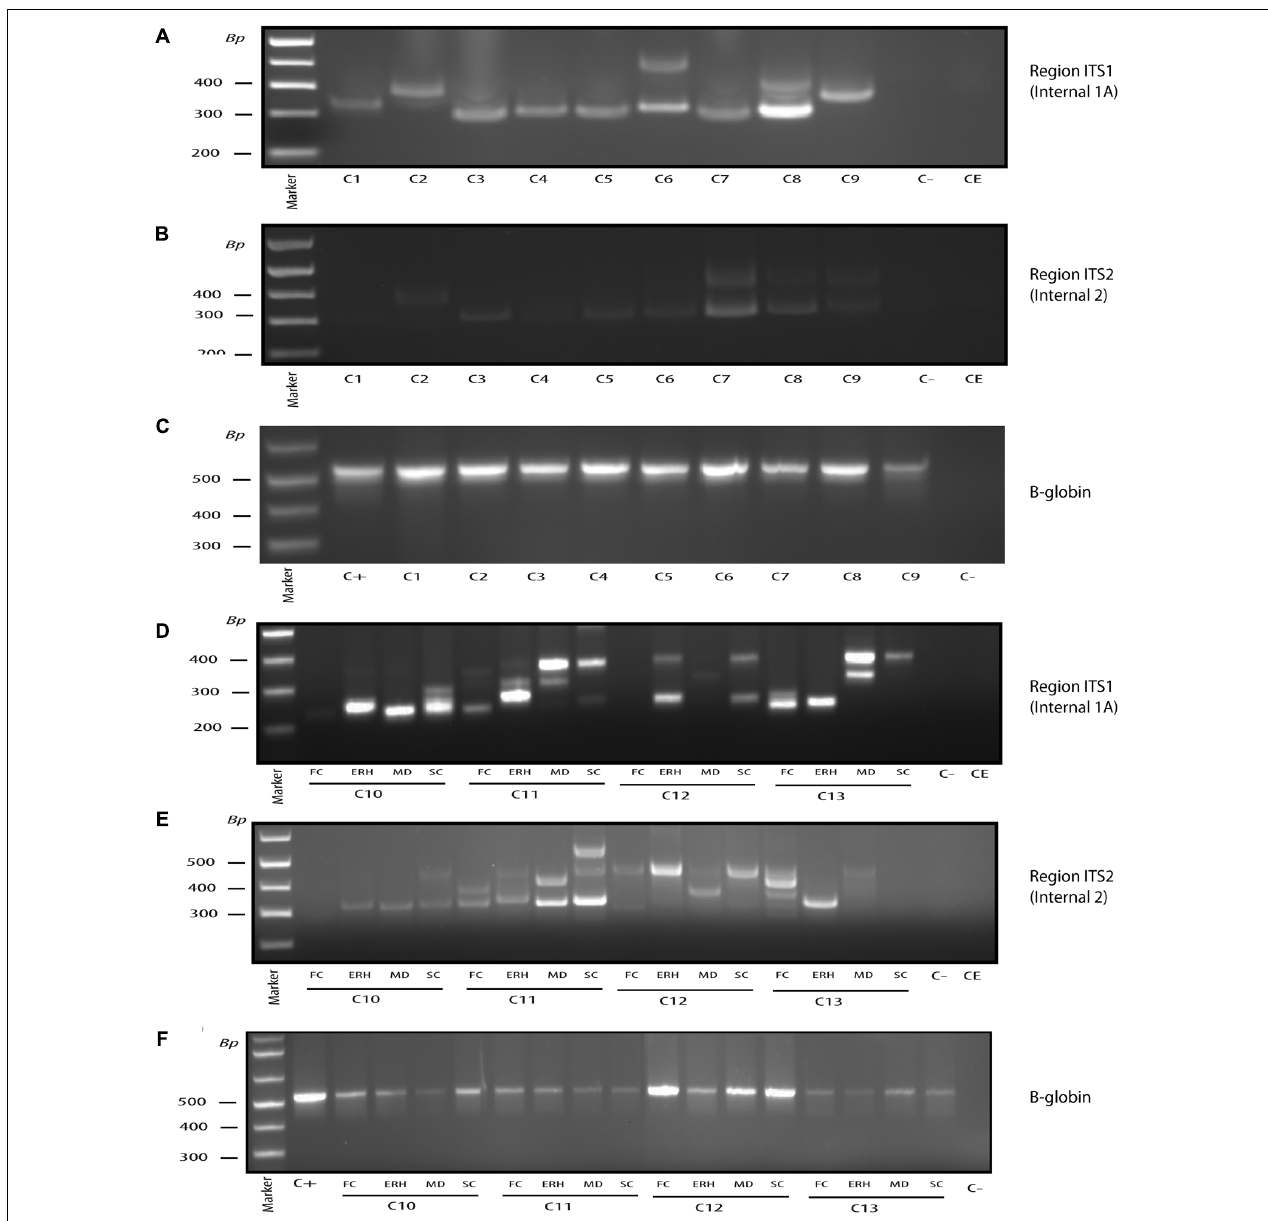
FIGURE 4 | Nested PCR of fungal DNA from control individuals. PCR analysis was carried out as described (see section “Materials and Methods”). Agarose gel electrophoresis of the DNA fragments amplified by nested PCR. PCR analysis of DNA extracted from frozen ERH tissue of nine controls using primers Internal 1A to amplify the ITS-1 region (A) . PCR analysis to amplify region ITS-2 from ERH of nine controls using primers Internal 2 (B) . PCR analysis of DNA extracted from the samples tested in (A,B) using human β -globin oligonucleotide primers (C) . PCR analysis from FC, ERH, MD, and SC of four controls using primers Internal 1A to amplify the ITS-1 region (D) . PCR analysis to amplify ITS-2 region of the same control samples indicated in (D) using primers Internal 2 (E) . PCR analysis of DNA extracted from the samples tested in (D,E) using human β -globin oligonucleotide primers (F) . Control–, PCR without DNA. CE, control of DNA extraction without DNA. C+, DNA extracted from HeLa